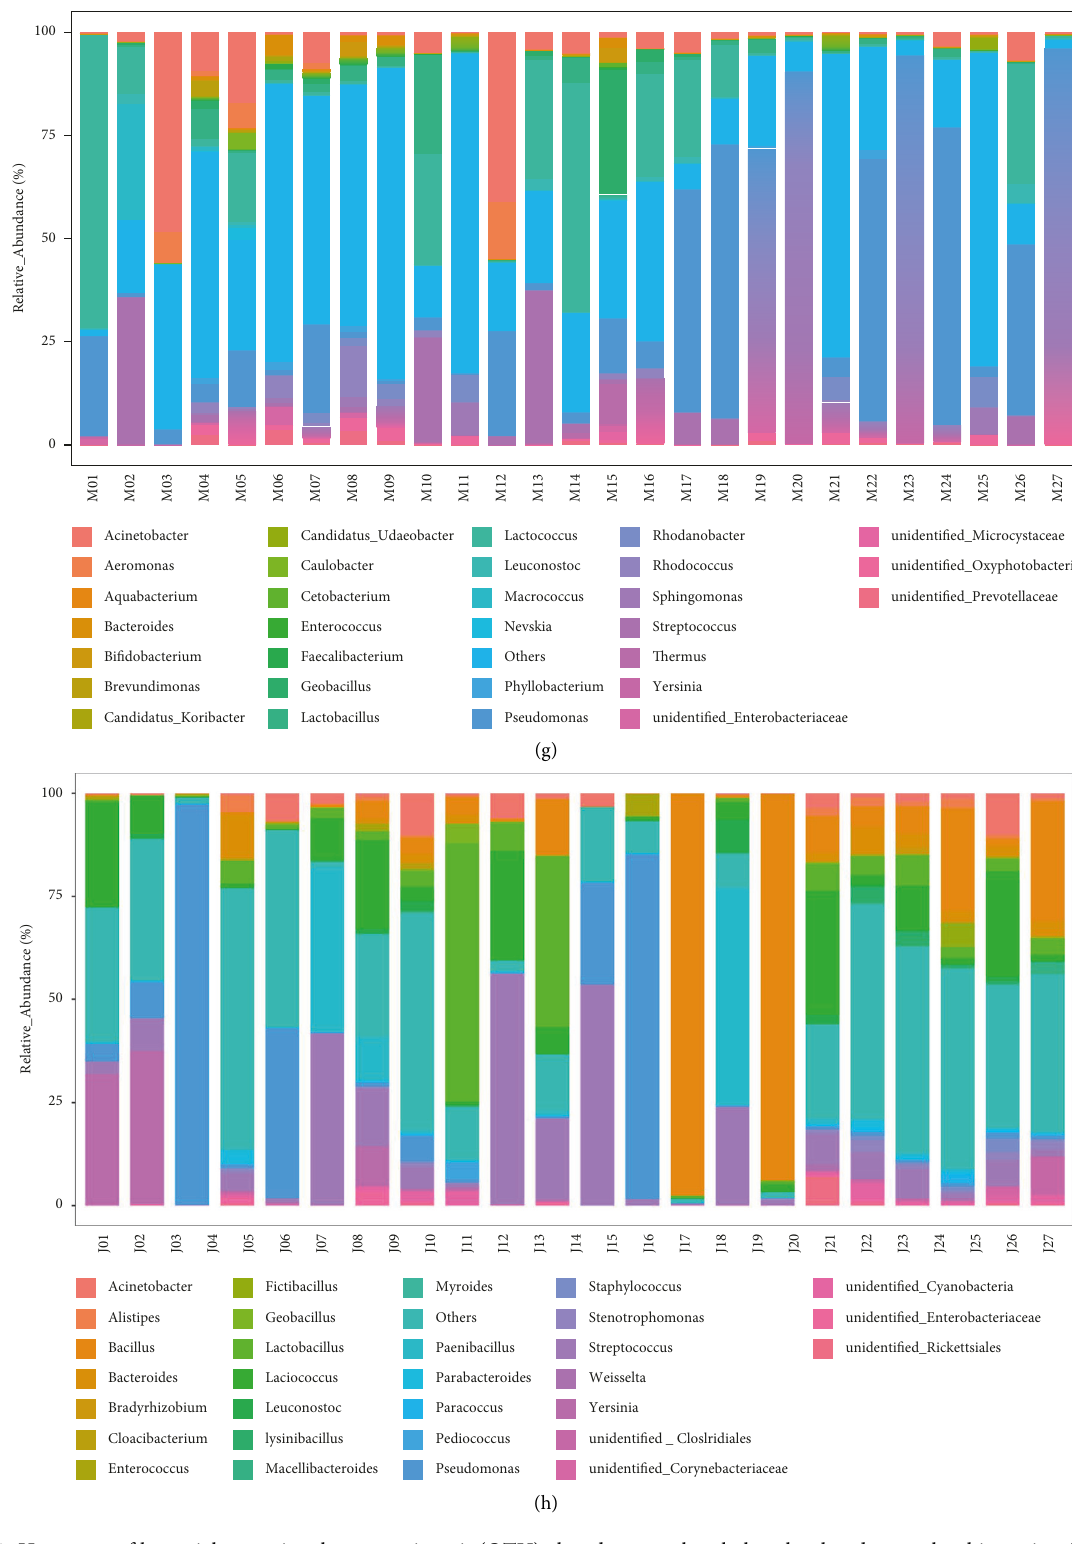
Figure 2: Heatmaps of bacterial operational taxonomic unit (OTU) abundance at the phylum level and genus level in spring (a) and (e), respectively, and summer (b) and (f), respectively; red indicates higher relative abundance. Relative abundance of bacterial species at the phylum and genus levels in spring (c) and (g), respectively, and summer (d) and (h), respectively. The diagrams show the mean relative abundance of top 10 phyla and top 30 genera in each